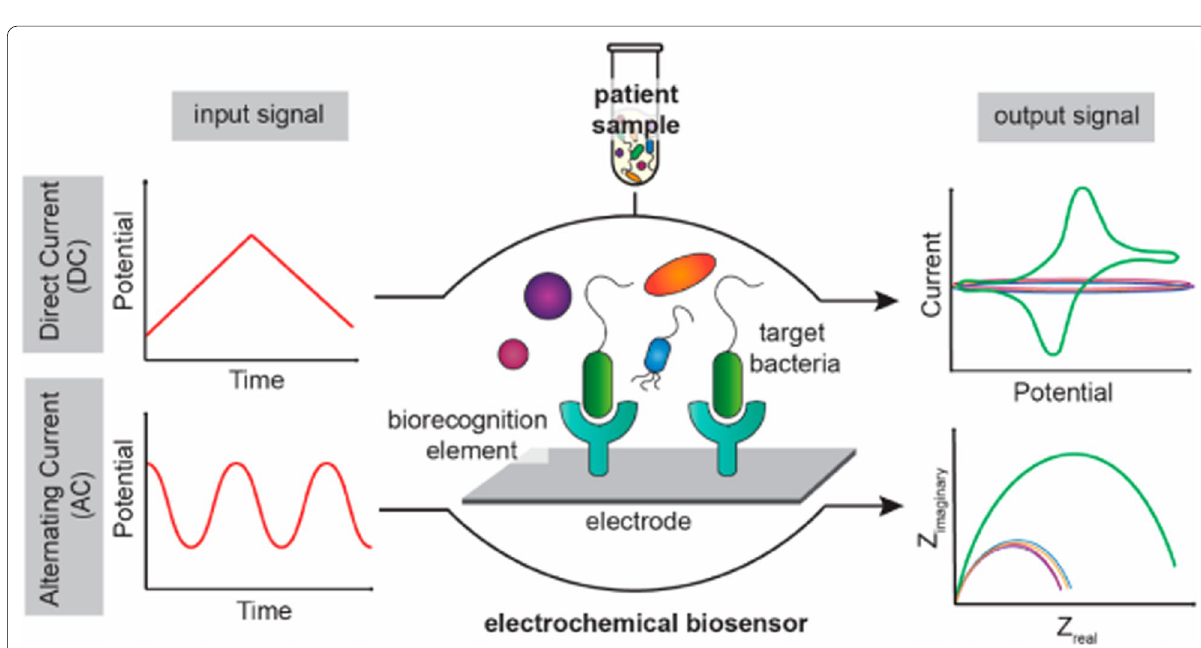
Fig. 4 Direct and AC current-derived electrochemical biosensors for bacterial detection (Karbelkar and Furst